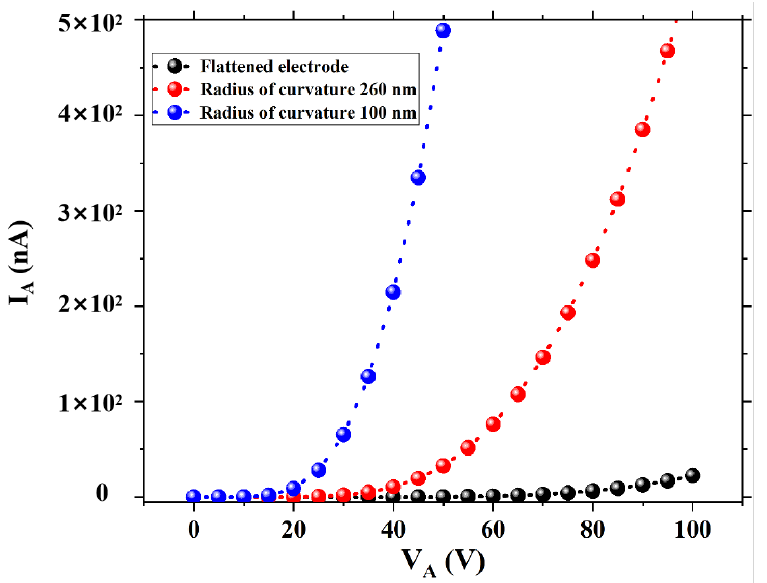
Figure 3. Emission current versus collector voltage for different emitter tip morphology.